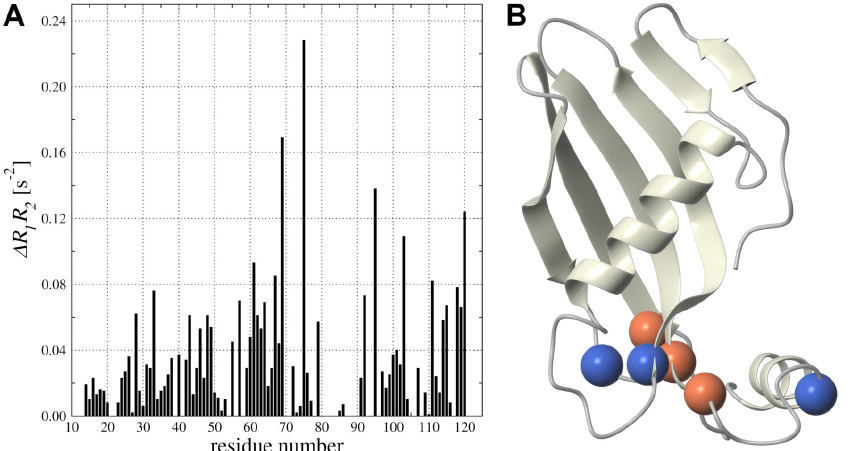
Figure 7. ( A) Differences in R 1 R 2 product calculated on the base of R 1 and R 2 relaxation rates measured in solution before and after addition of DMPC- d 54 ; ( B ) Ribbon representation of the 3D structure of h CC V57G with residues exhibiting increased conformation exchange mobility (Ser44, Asn82, and Asp119) and changes after addition DMPC- d 54 (Gly69, Lys75, and Ala95) shown as blue and red marbles,